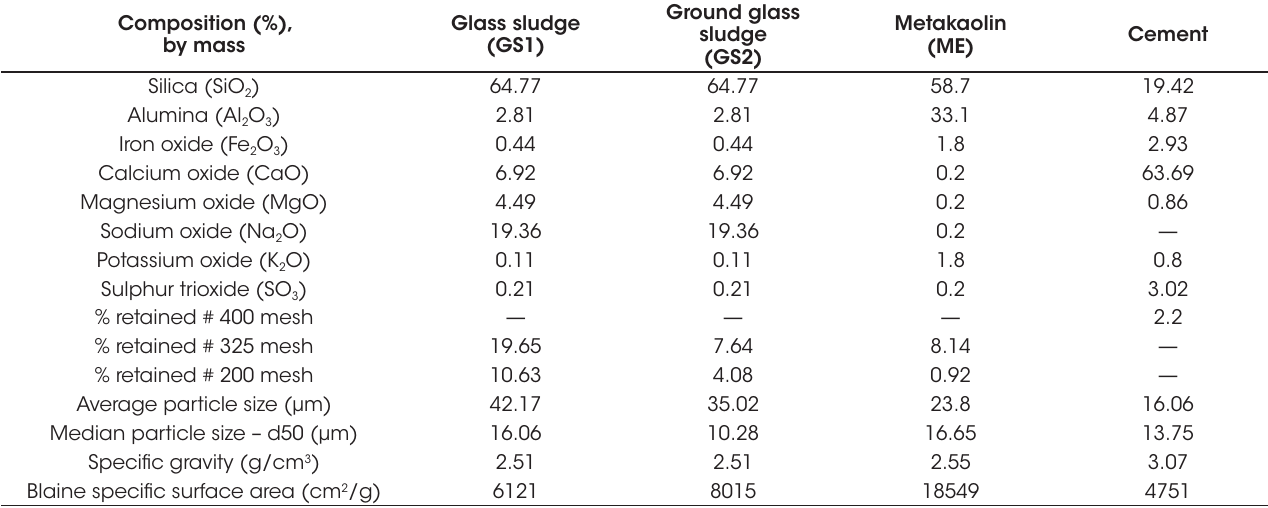
Physical and chemical properties of GS1, GS2, metakaolin and cement Composition (%), by mass